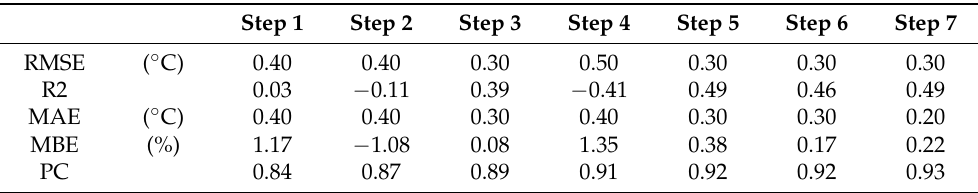
Table 6. Averaged results for each of the statistical analysis metrics through the calibration process